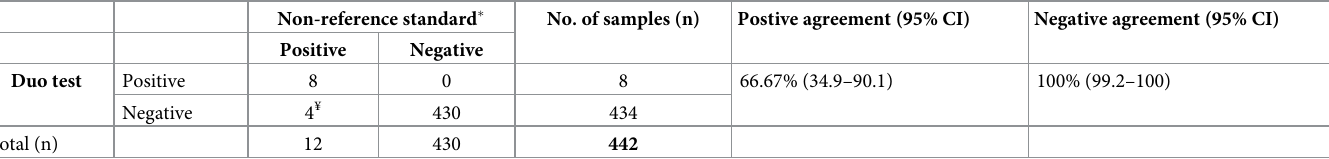
Table 2. Comparison of the diagnostic agreement between SD Bioline Duo HIV test component results and the Alere Determine TM HIV 1/2 test results. Non-reference standard (cid:3)